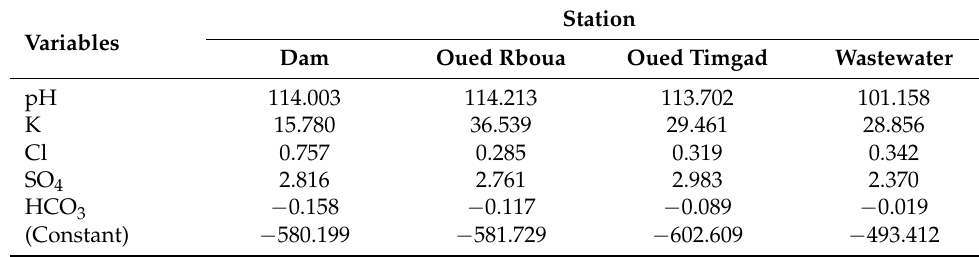
Table 13. The classification function